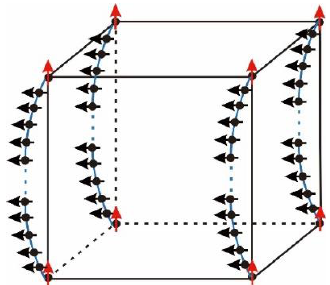
Figure 4. A braid is mapped to a spin-chain lattice.